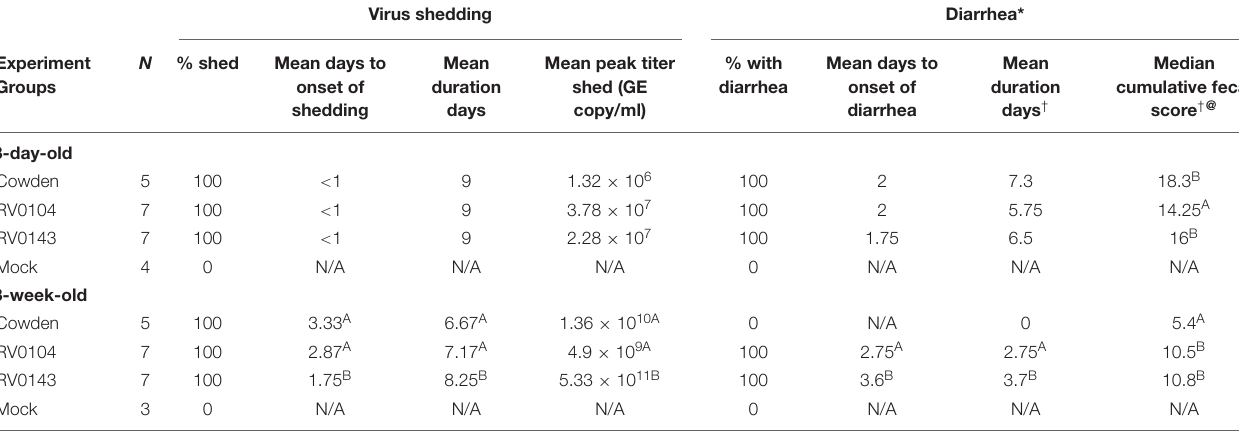
TABLE 1 | Summary of porcine RVC diarrhea and fecal virus shedding in Gn piglets after PRVC inoculation (PID1 to PID10). Virus shedding